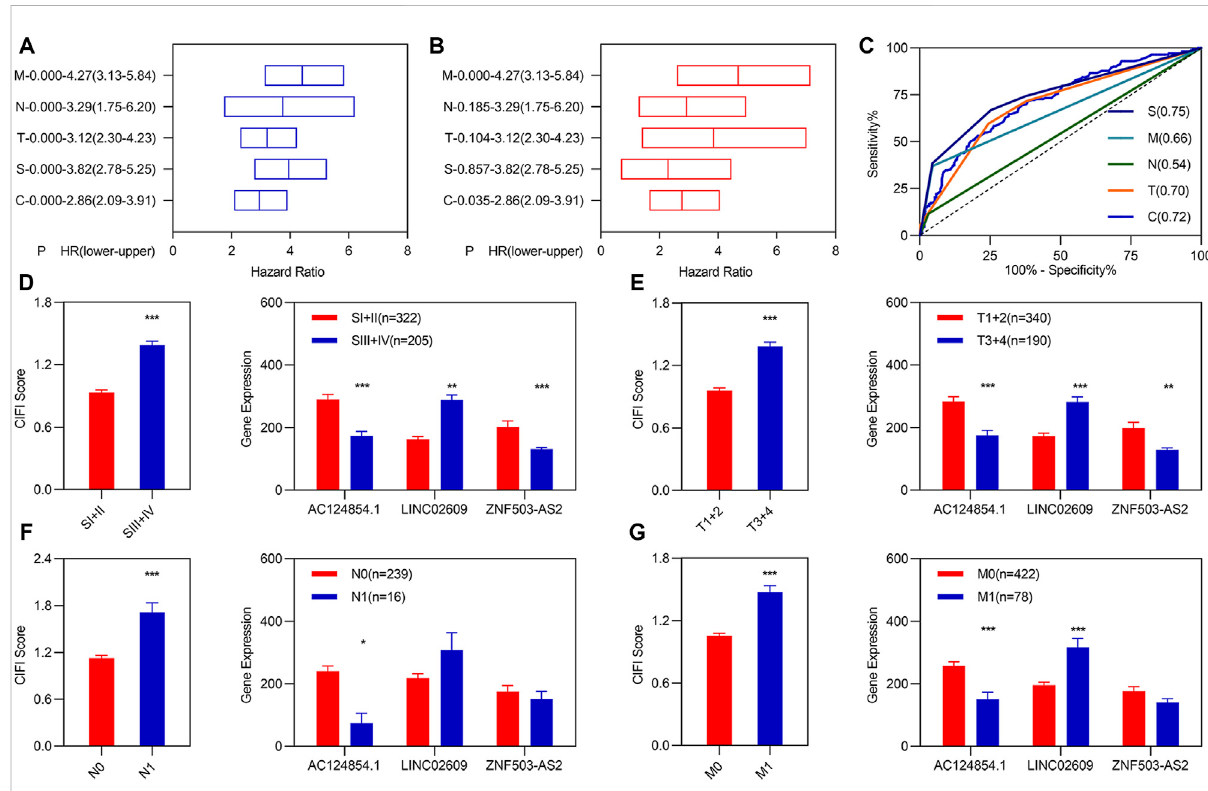
FIGURE 3 IndependentprognosticvaluesofthethreeFI-DELs. (A) K-Manalysisillustrateddifferentclinicalcharacteristics,andCIFIvalueswerecorrelated withOSofpatientswithKIRC. (B) MultivariateCoxregressionanalysisillustratedpathologicM,andCIFIvalueswerecorrelatedwiththeOSofpatients with KIRC independently. (C) ROC curve of different clinical characteristics and CIFI value. (D – G) CIFI score and expression of the three FI-DELs within different clinical characteristics. * p < 0.05, ** p < 0.01, *** p <